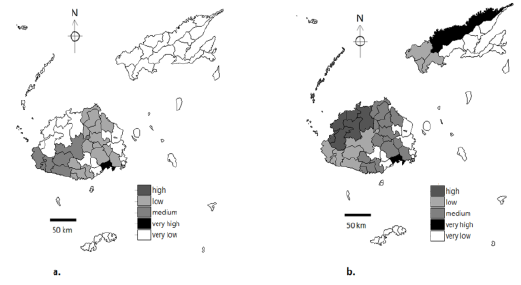
Figure 10a . LUI of farms of less than 1ha size. Figure 10b. LUI of farms of 1-3ha size.